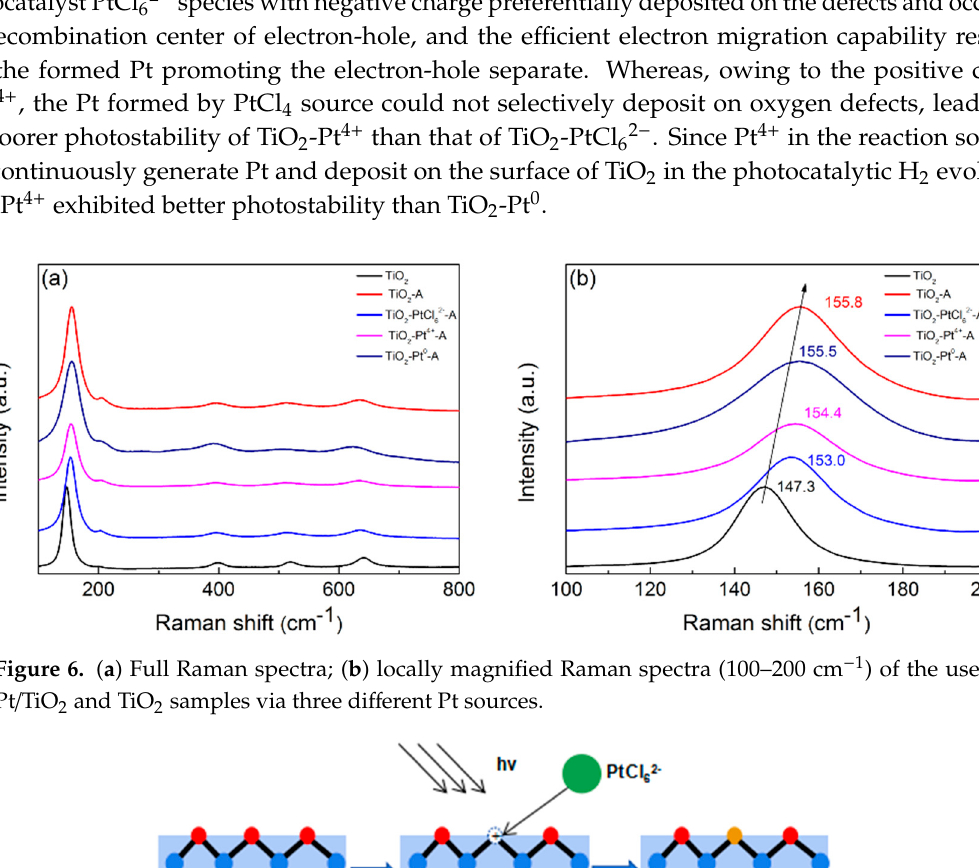
Figure 7. Scheme diagram of PtCl 62 − source improving photostability of TiO 2 .